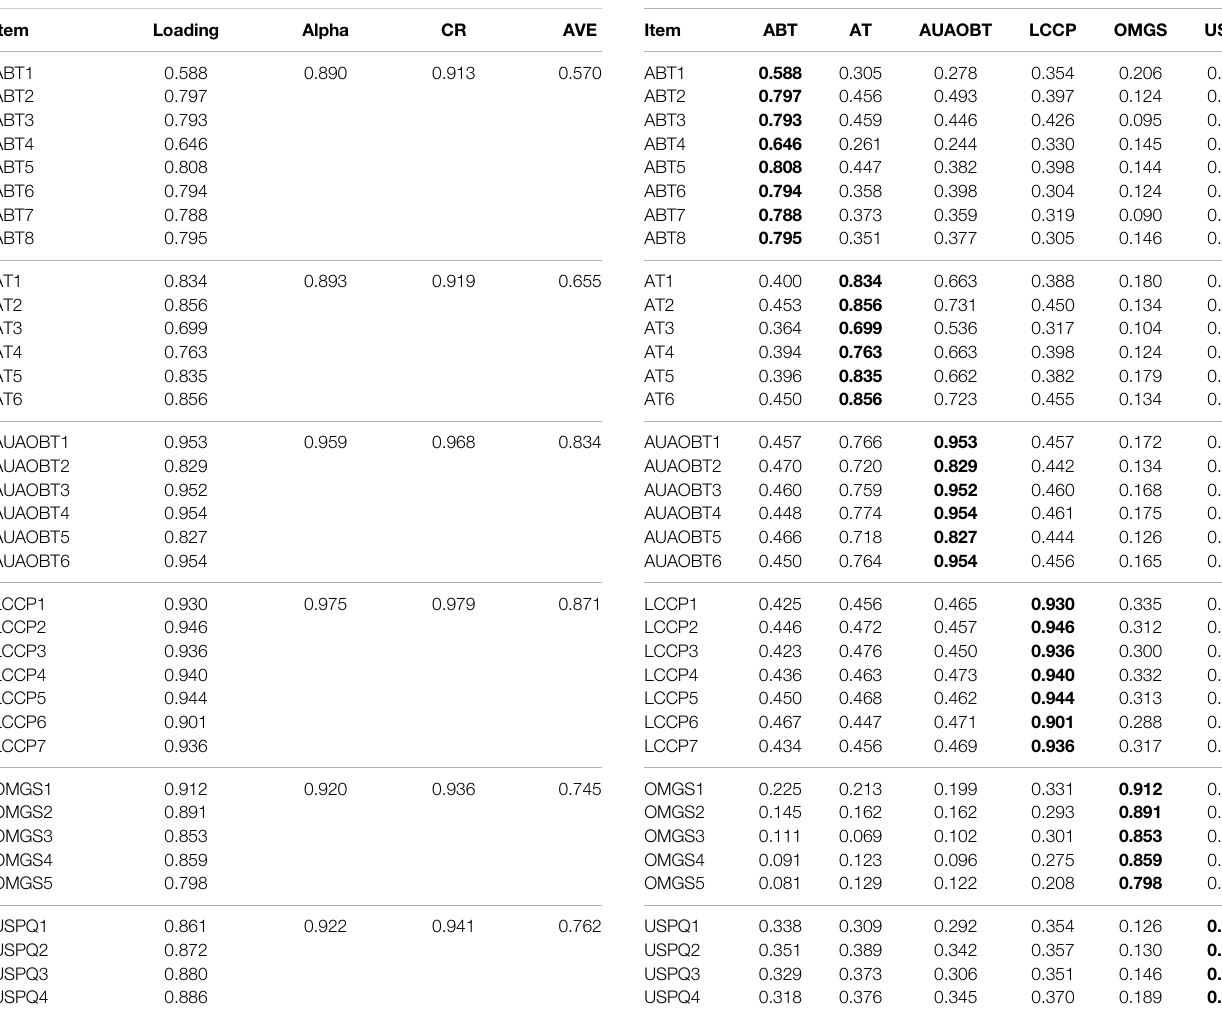
TABLE 2 | Convergent validity analysis.